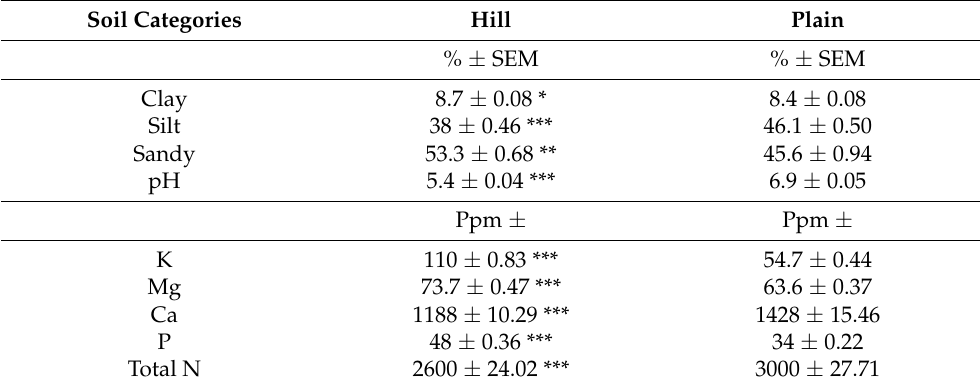
Table 2. Type of soil in hill and plain orchards a .